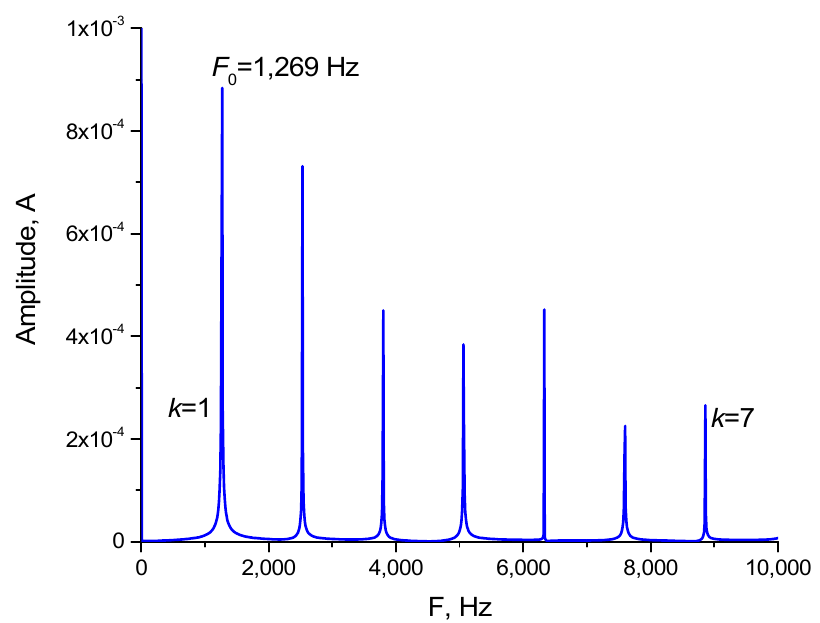
Figure A3. Examples of calculated oscillograms sections (1000 points), voltage U 0 and current I sw_0 , for the oscillator with i = 0 at I p_0 = 1200 µA. Here we do not show other circuit parameters because other oscillators do not affect this one.